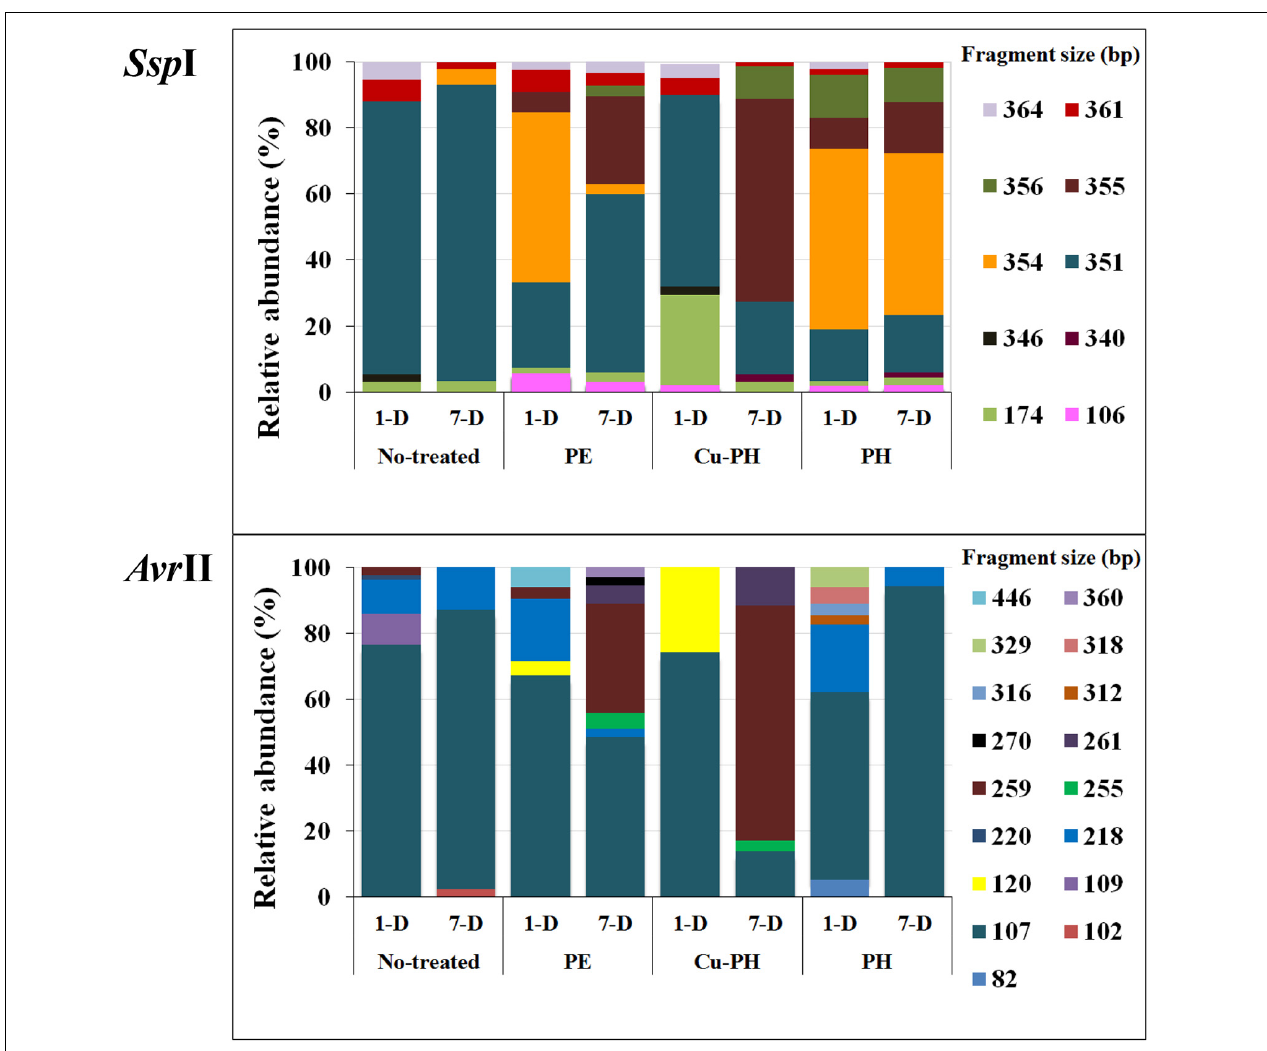
FIGURE 2 | Percentage of relative abundance of T-RFs after Ssp I and Avr II digestion among no-treated and PE-, Cu-PH-, and PH-treated samples at 1 and 7 days after the last treatment. The numbers indicate the size (in bp) of the T-RF fragments.